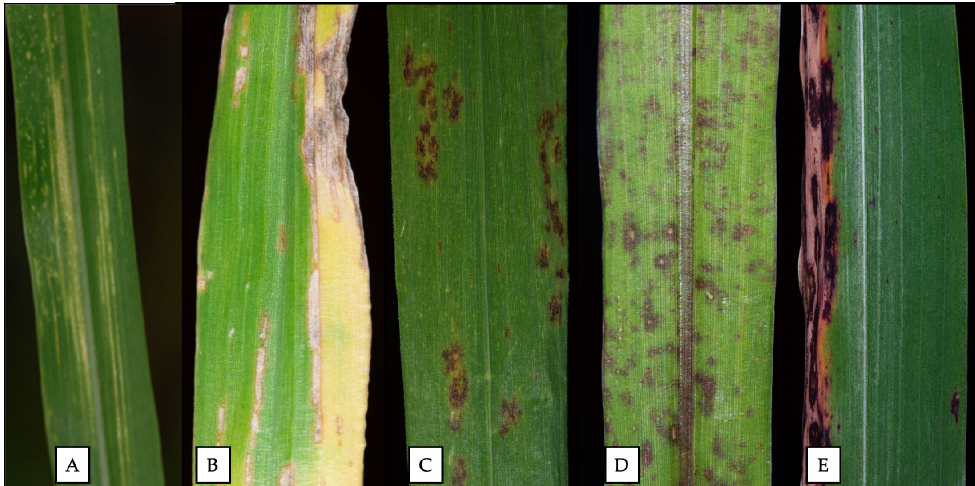
Figure 3. Leaves of forages and weeds showing symptoms of bacterial leaf streak (BLS) 15 days after inoculation (DAI) with the RL1 strain of Xanthomonas vasicola pv. vasculorum ( Xvv ): ( A ) Brachiaria brizantha (Brizantha) with symptoms of BLS; ( B ) Digitaria insularis with symptoms of chlorosis; ( C ) Echinochloa colonum with red spots; ( D ) Digitaria horizontalis with reddish punctuations; and ( E ) Sorghum arundinaceum with red spots on the leaf surface and necrosis in the leaf margin. In oat, the lesions, initially brownish ‐ yellow in color, were numerous and coalescent, covering a substantial part of the leaf surface. Some areas also became chlorotic (Figure 2A–C). Several lesions were evident on oat, but the severity of the symptoms was not